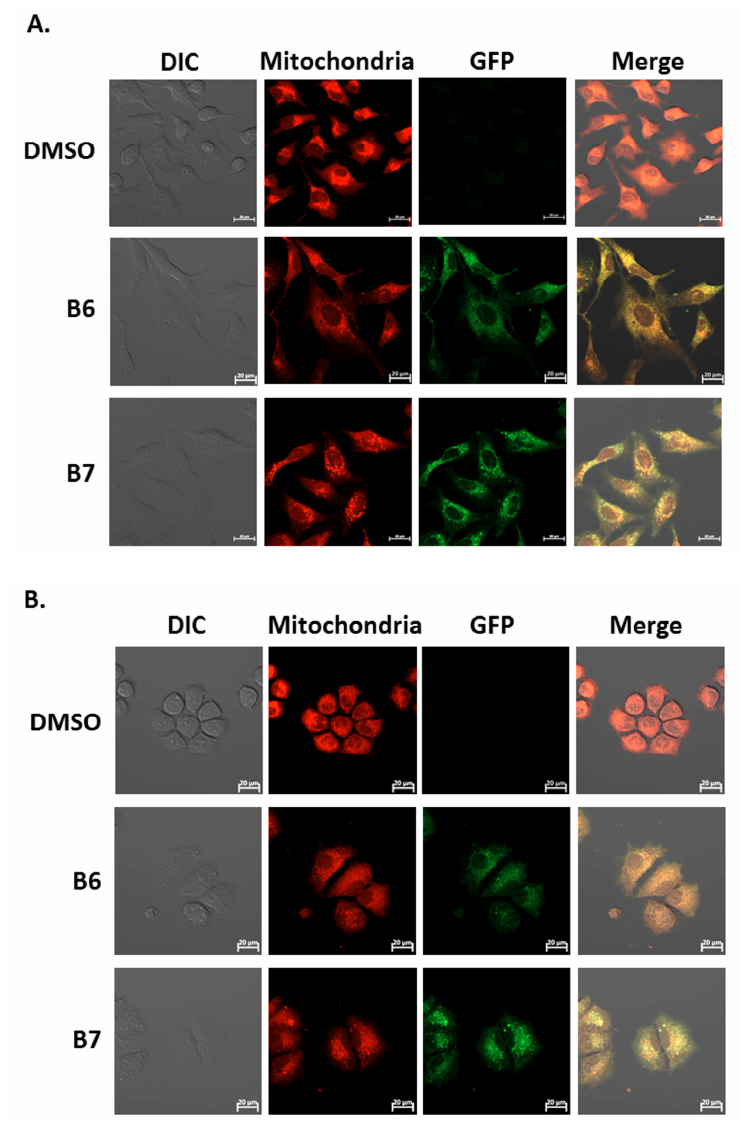
Figure 7. The uptake and localization of B6 and B7 in non-small-cell lung cancer cells. ( A ) A549 and ( B ) H1435 cells were incubated with control medium or B6 and B7 for 24 h, and the mitochondria was stained with mitotracker and determined under confocal microscope. The expression and the localization of B6 and B7 were shown by excitation at 488 nm, and the emission of green fluorescence from B6 and B7 was observed under a confocal microscope.